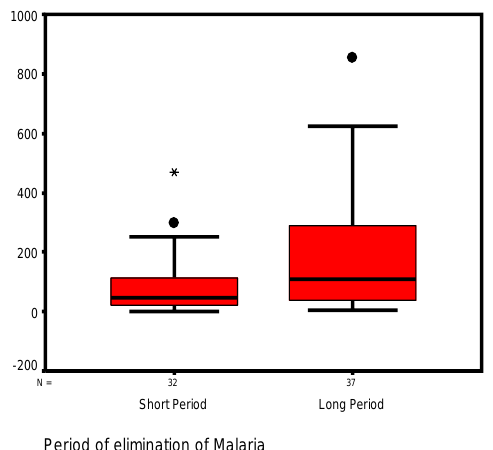
Fig. 2. Stem-Leaf plots of (COVID -19 deaths/M as it was in 2nd of September 2020) versus duration of time period since elimination of